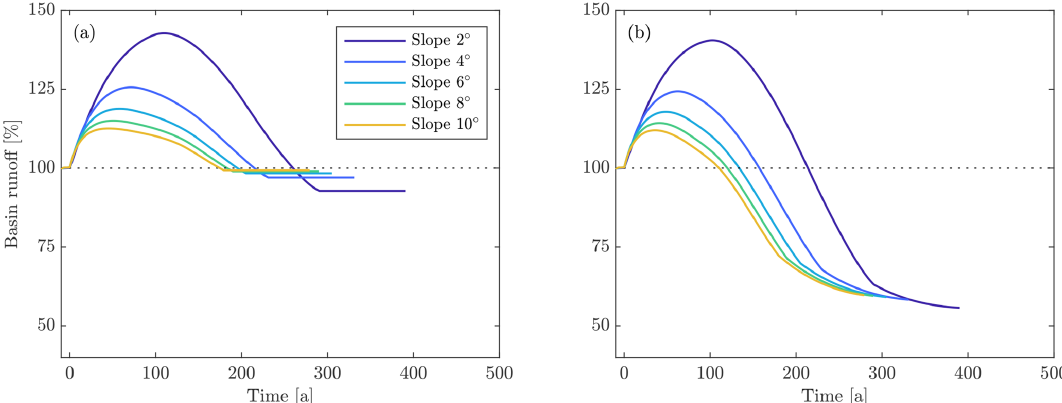
Figure 3. Variations in basin runoff (a) without vegetation and (b) with vegetation. For both (a) and (b) we use a maritime climate and the RCP8.5 climate change scenario. In (b) we set the vegetation timing and type as T = { 20 , 50 , 100 } and C = { 1 , 0 . 9 , 0 . 8 , 0 . 6 } , respectively.